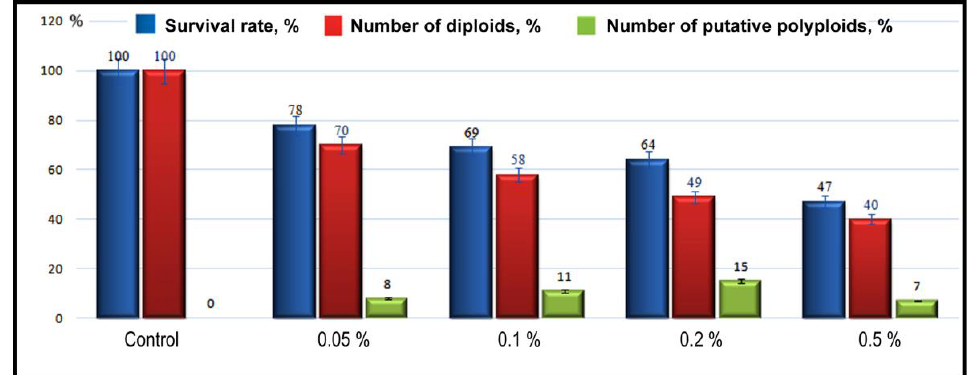
Figure 1. Influence of different concentrations of colchicine on the survival rate and polyploidy induction in Polemonium caeruleum .